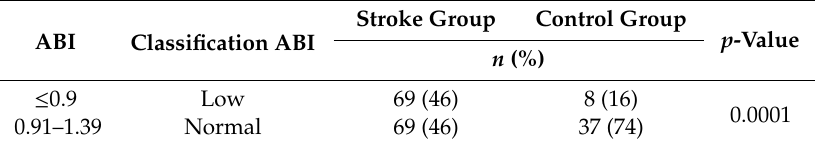
Table 3. Distribution of normal and low ankle–brachial index (ABI) values in the stroke and control groups (excluding ABI > 1.4).